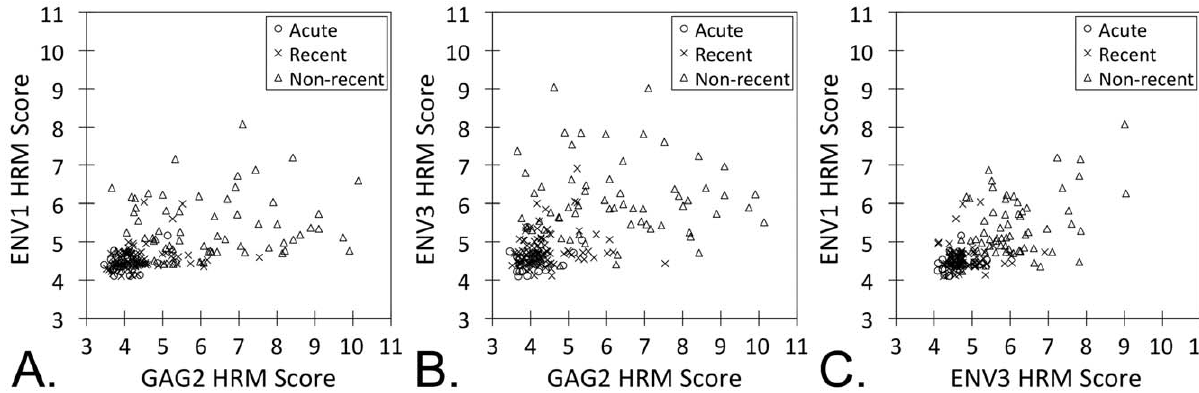
Figure 3. Relationship between HRM scores for the ENV1, ENV2, and GAG2 regions. Scatter plots are shown for HRM scores for adults with acute, recent, and non-recent infection: (A) ENV1 vs. GAG2, (B) ENV3 vs. GAG2, and (C) ENV1 vs.